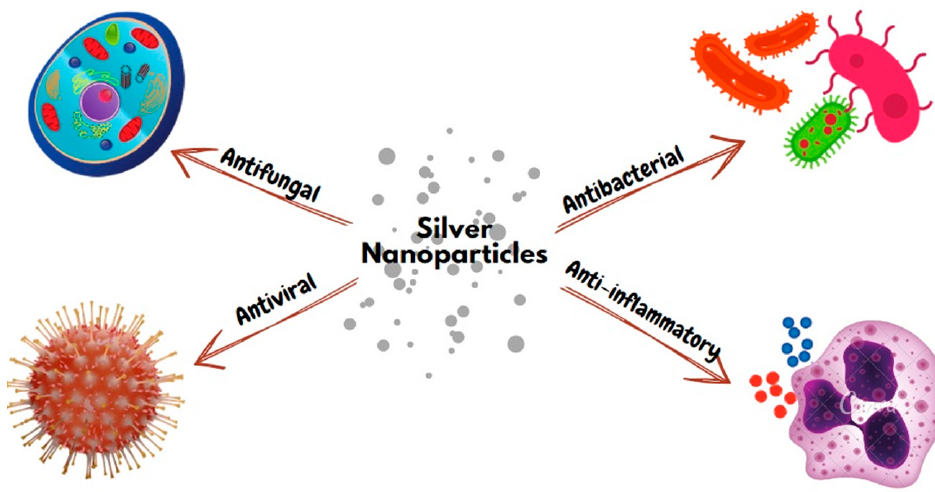
Figure 1. Biological activities of silver nanoparticles.